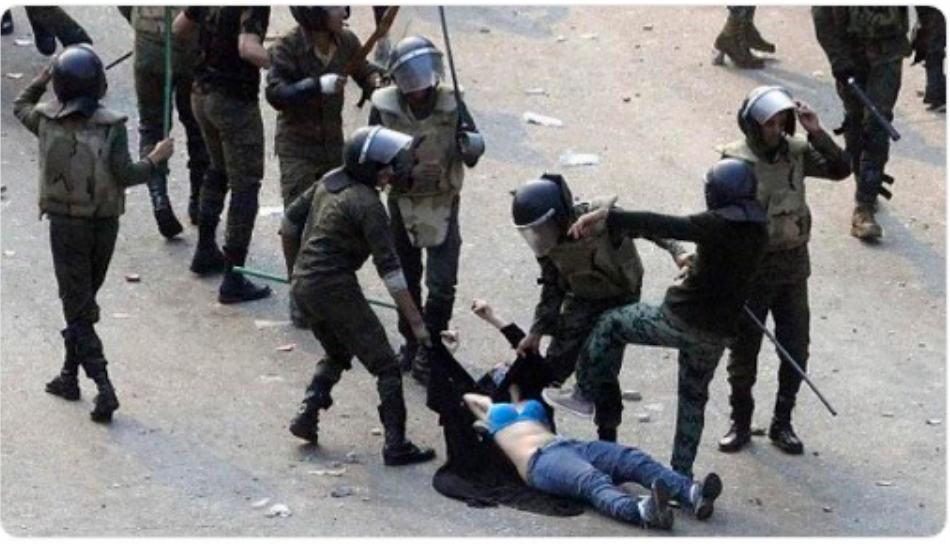
Figure 5. Mai El-Saday tweet with picture of ‘blue bra girl’. 8 March 2017.